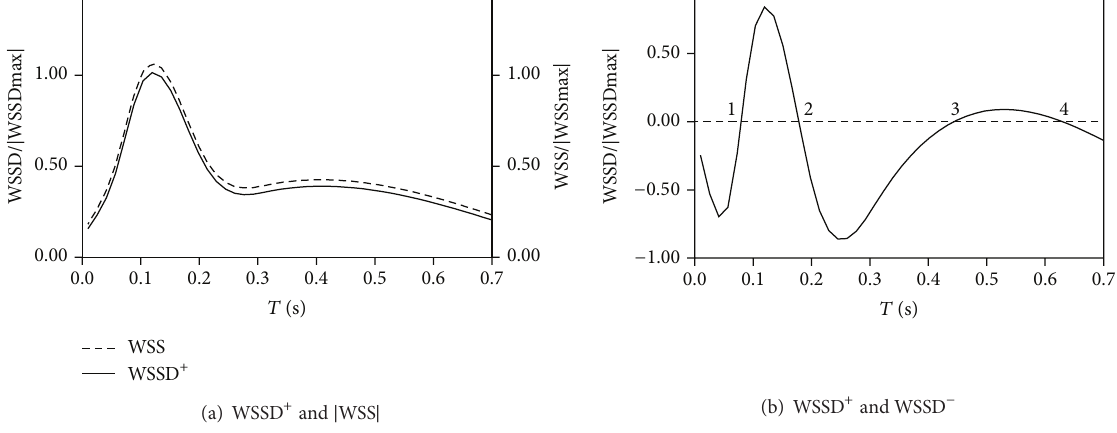
Figure 4: WSSD versus time for case 1.